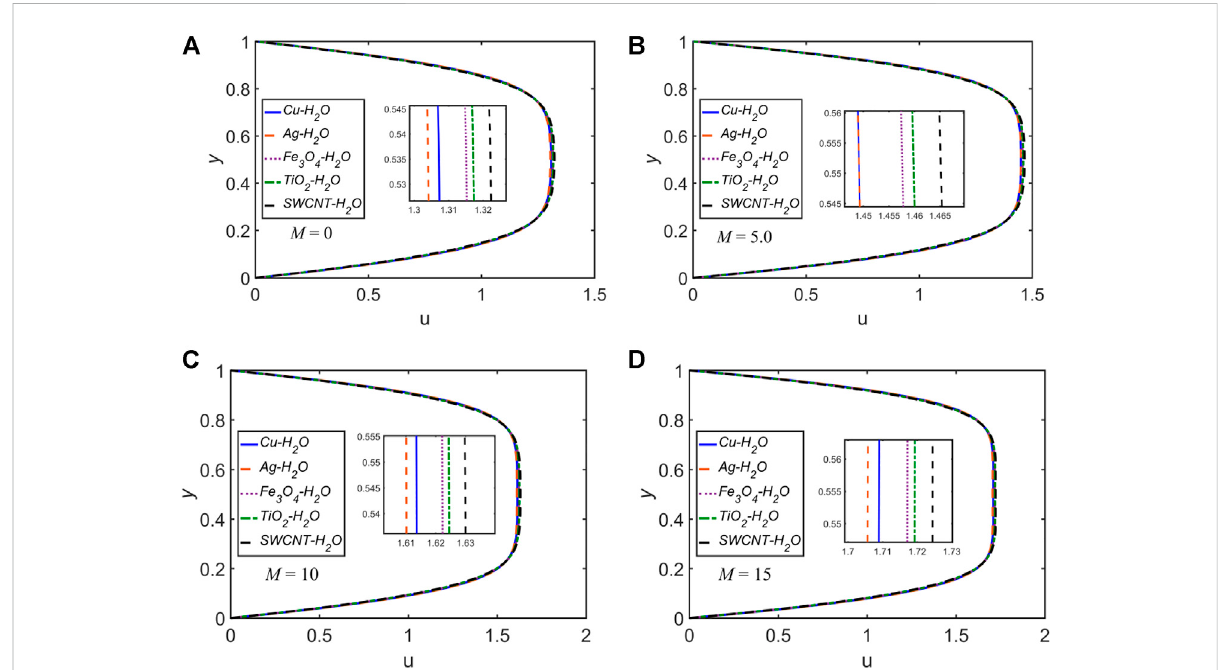
The velocity pro fi le u versus y at x (cid:2) 0 and t (cid:2) 0 . 25 for the fi ve NFs for distinct values of M